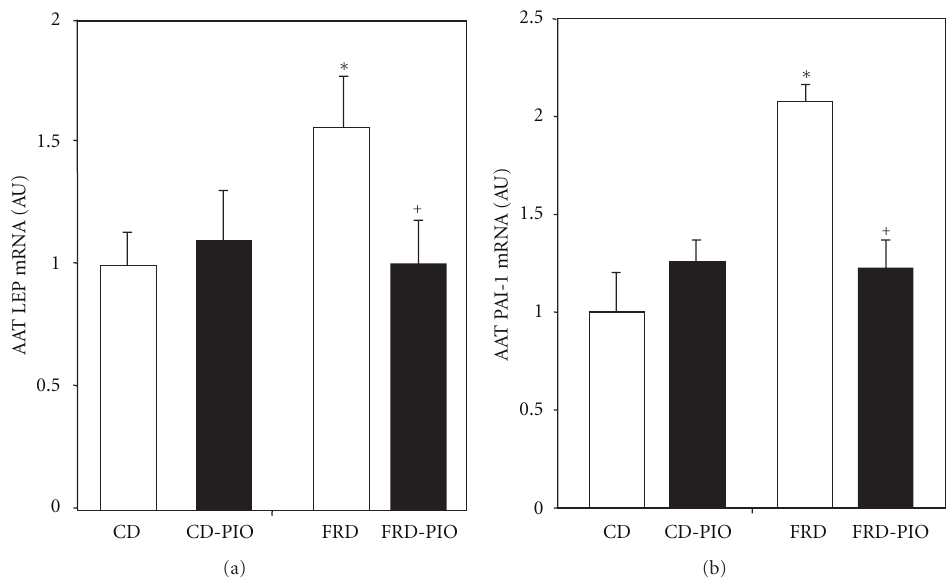
Figure 3: LEP (a) and PAI-1 (b) mRNA abundance in AAT pads from CD and FRD rats without or with PIO treatment. Data (expressed in arbitrary units: AU) were normalized to the levels of ACTB, and then presented as relative to values obtained in fat pads from CD rats. Means ± SEM ( n = 5/6 pads per group). ∗ P < 0.05 versus CD; + P < 0.05 versus FRD.